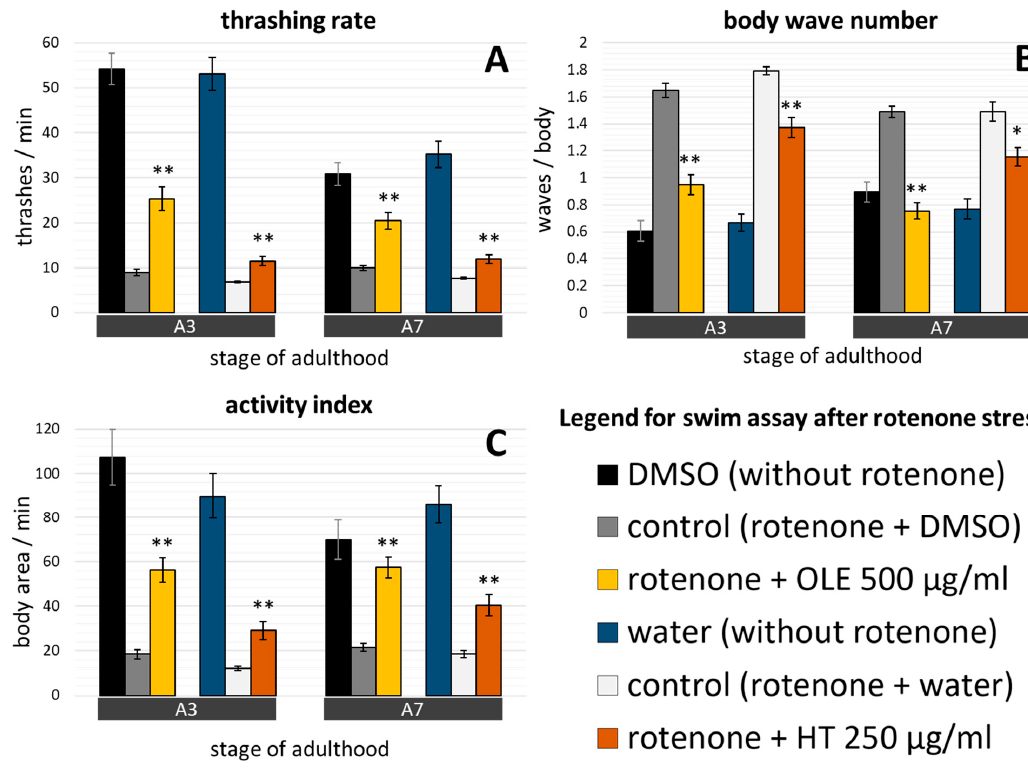
Figure 6. E ff ect of OLE and HT on rotenone-induced locomotion deficits. The administration of 10 µ M rotenone, starting at the fourth larval stage, led to Parkinsonian-like phenotype exhibiting movement impairments at the 3rd and 7th day of adulthood. ( A ) The thrashing rate, ( B ) the body wave number, and ( C ) the activity index are shown with and without simultaneous OLE or HT